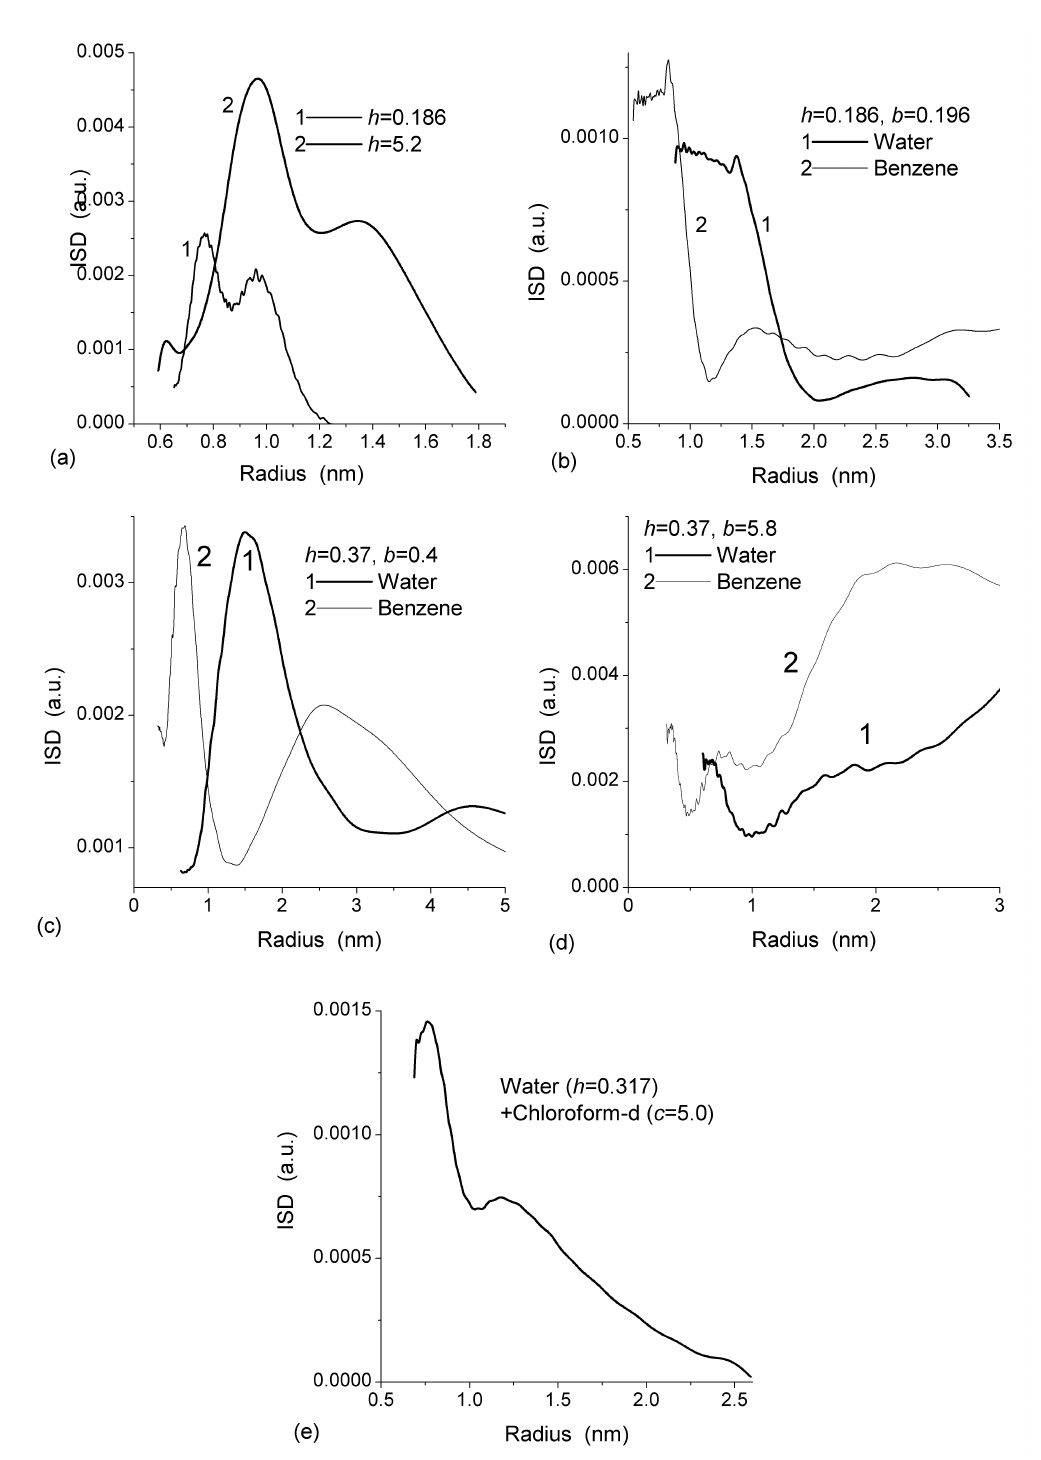
Fig. 13 Distribution function of sizes of structures unfrozen liquids in MCM-41 (sample 2) pores: (a) pure water, (b, c, d) water and benzene, and (e) water (with the presence of chloroform- d ) calculated using Eqs. (4) and